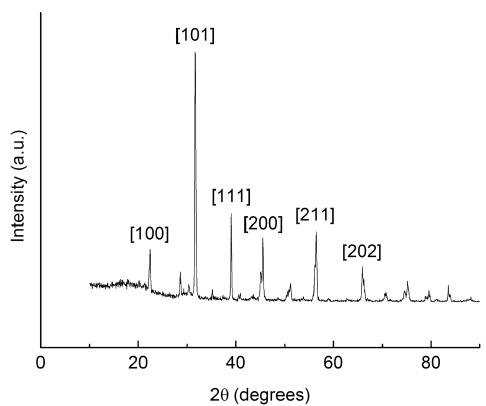
Figure 1. X-ray diffraction pattern of a BaTiO 0.2 mol% Gd. The indices were taken from JCPDS no. 81-2203.